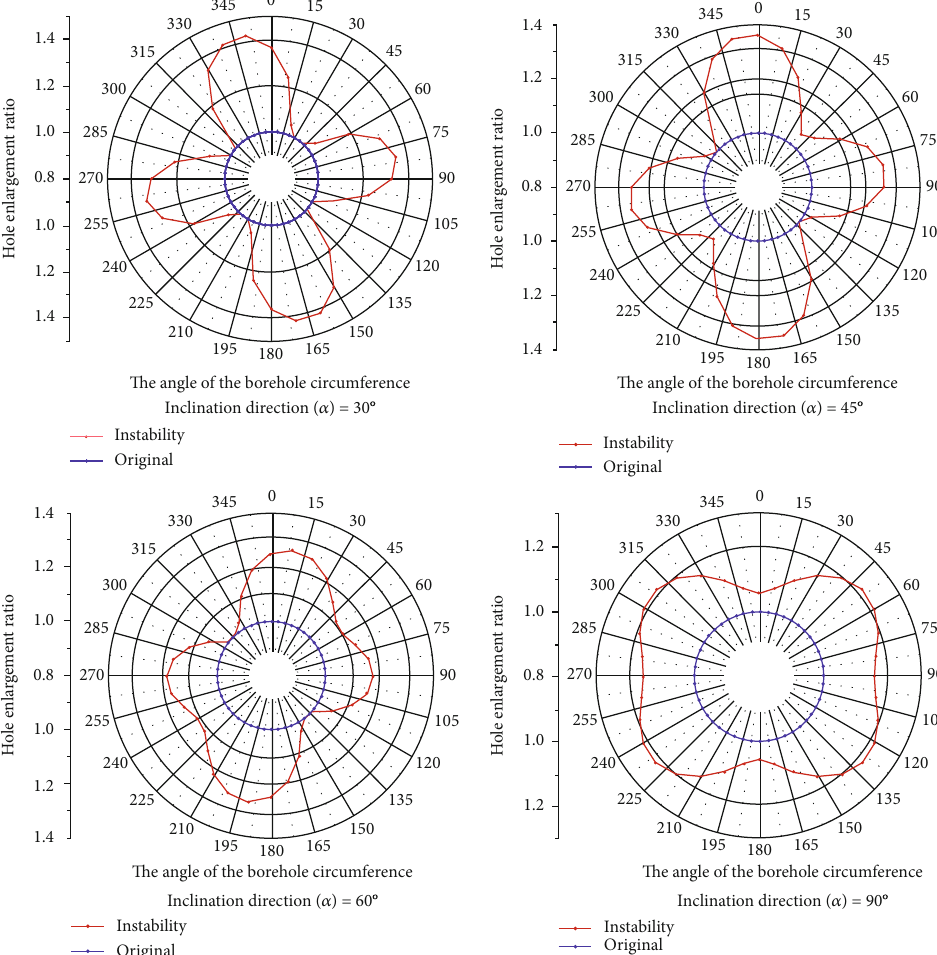
Figure 7: Characteristic shape of wellbore caving at 30 ° inclination angle of bedding